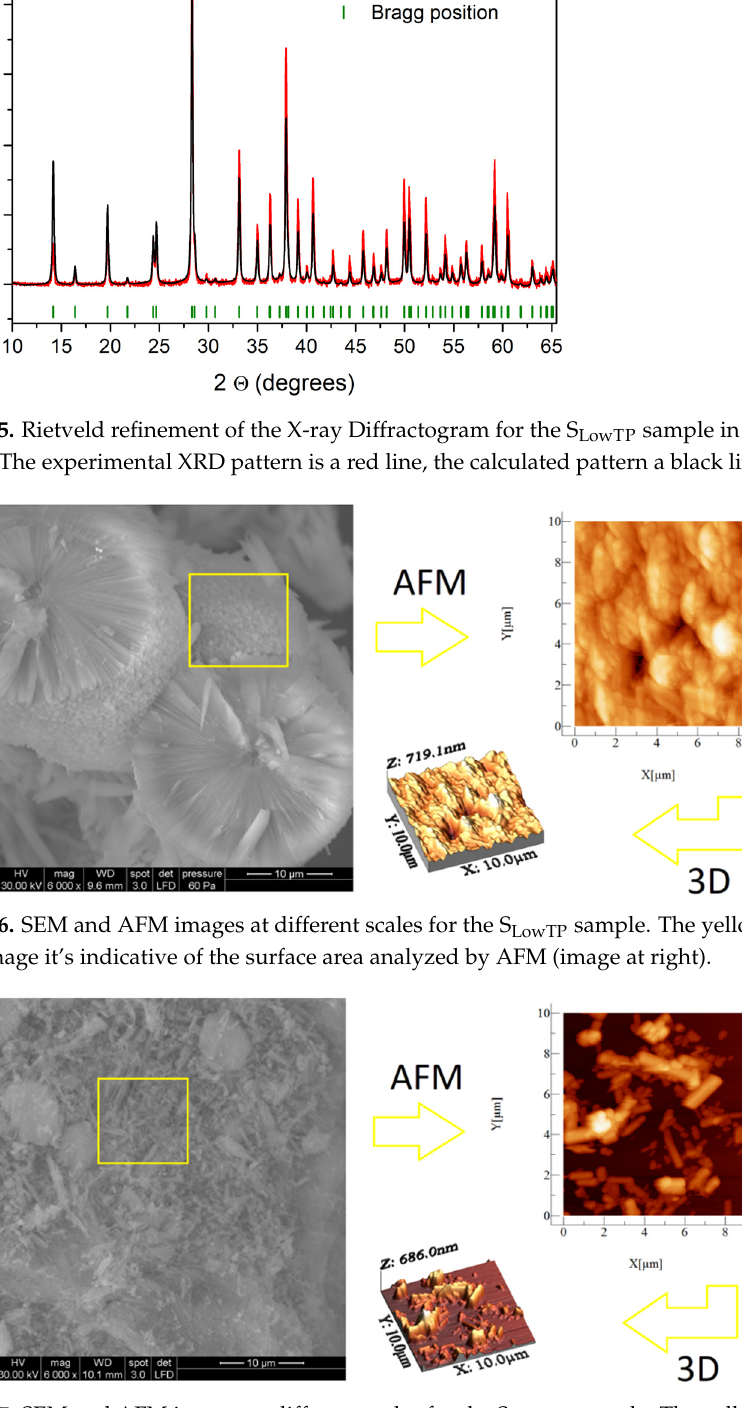
Figure 5. Rietveld refinement of the X-ray Diffractogram for the S LowT P sample in the P6 3 mc space group. The experimental XRD pattern is a red line, the calculated pattern a black line.